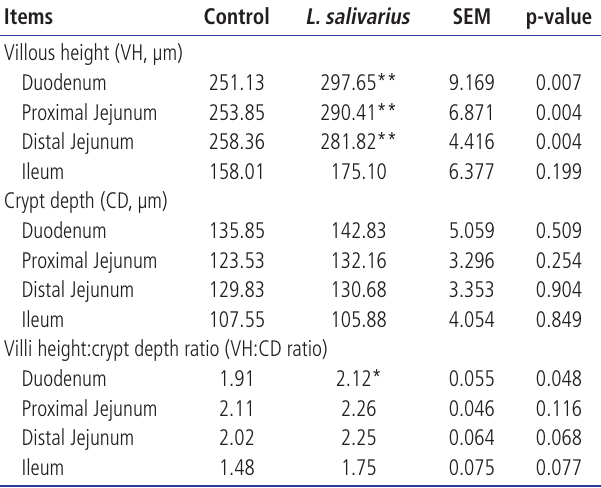
Table 7. Effect of Lactobacillus salivarius on intestinal morphology of piglets challenged with Escherichia coli F4